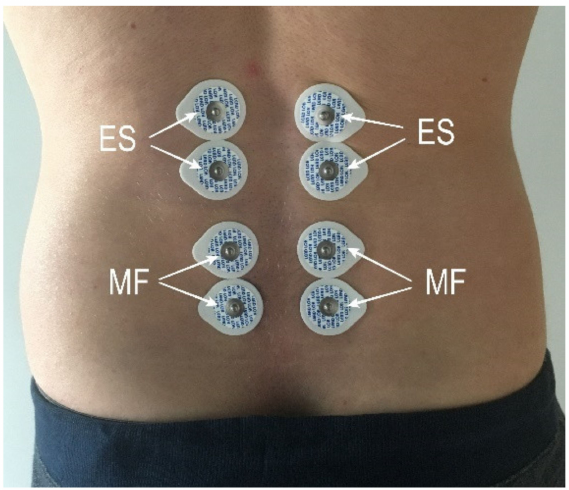
Figure 2. Arrangement of surface